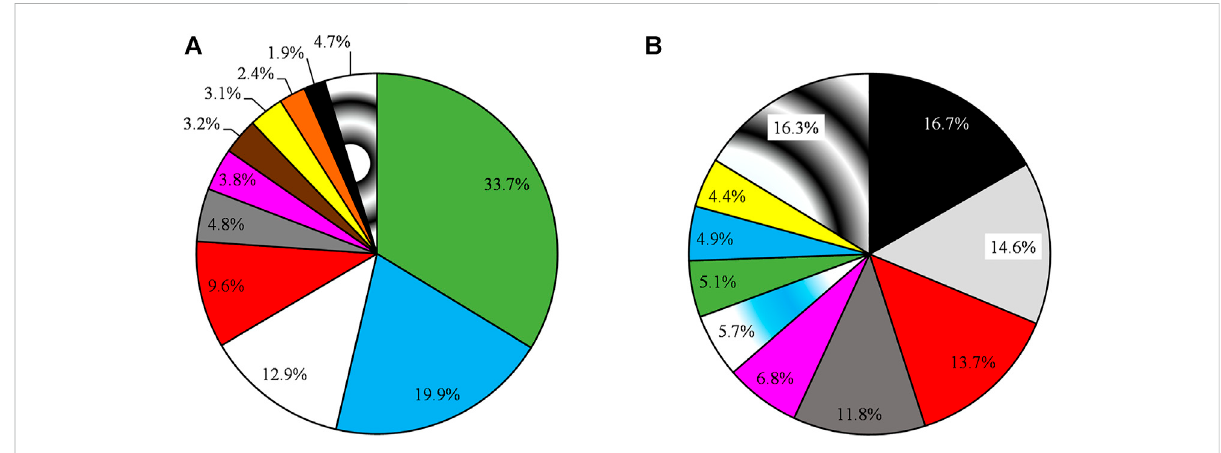
FIGURE 7 Color composition of fragments collected at st1 (A) and of fi bers collected from the six stations (B) . The black and white slice corresponds to a pool of other colors. The light grey slice in (B) represents transparent fi